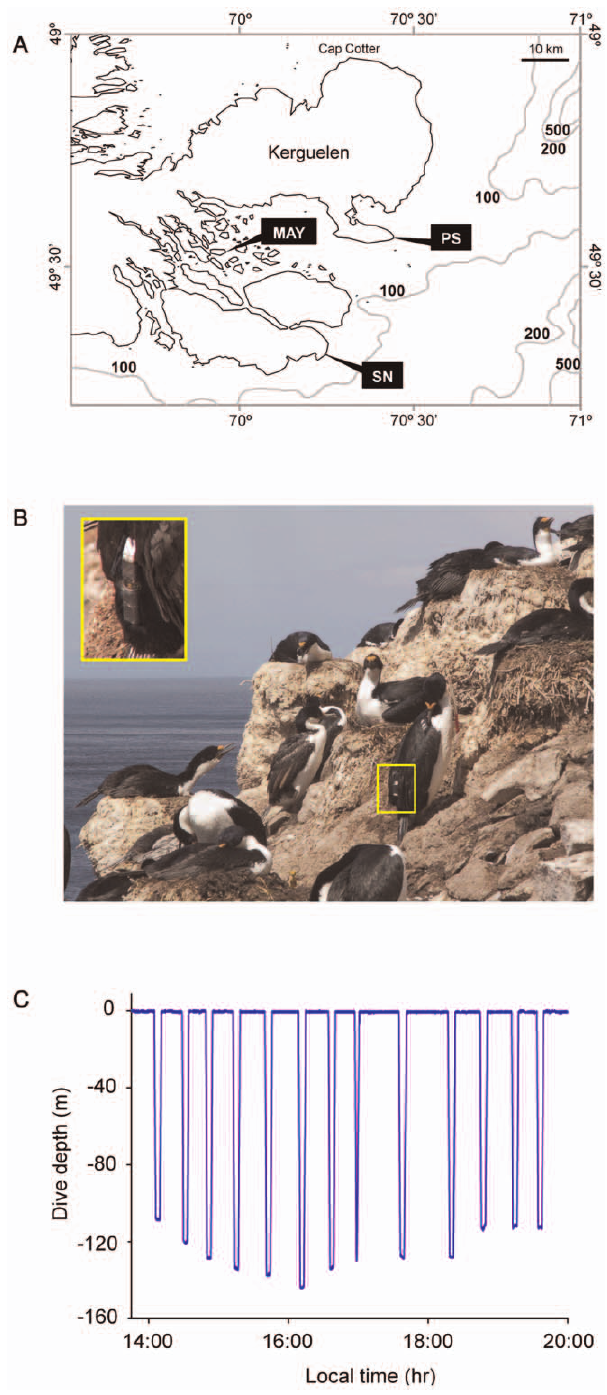
Figure 3. Position of study colonies of Kerguelen Shags and example of individual dive profile recorded by temperature- depth recorder. (A) Map of Kerguelen with the three colonies of Kerguelen Shags monitored in this study: Maye`s (MAY), Pointe Suzanne (PS) and Sourcils Noirs (SN). (B) Bird equipped with a temperature-depth recorder (Sourcils Noirs colony). Photo: Timothe´e Cook. (C) Complete daily dive recording of a male bird from the Sourcils Noirs colony. Dive n u 6 reached a maximum depth of 144 m and dive n u 9 lasted 6.72